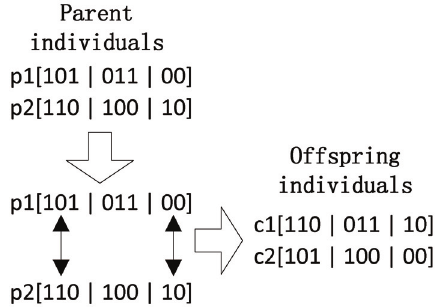
Fig. 2. An example of a two-point